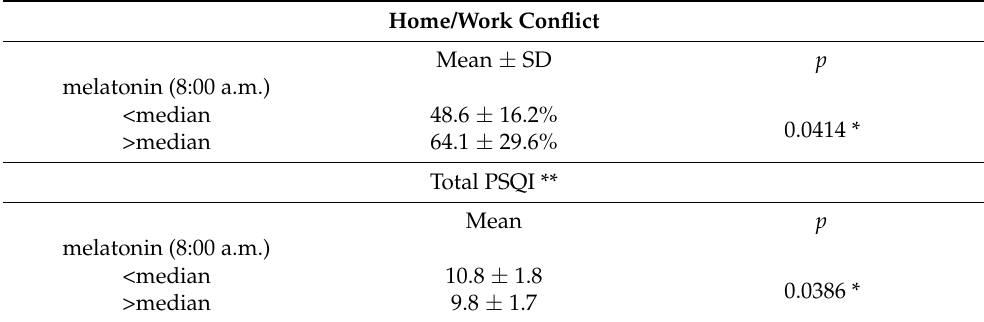
Table 4. Association of melatonin levels with the subclass home–work conflict of the PSS and PSQI. Home/Work Conflict Mean ± SD p melatonin (8:00 a.m.) <median